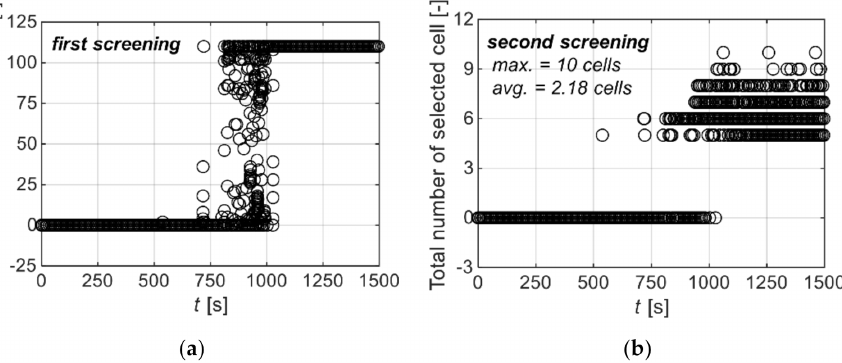
Figure 13. Total number of cells selected by the proposed algorithm: ( a ) at first screening and ( b ) at second